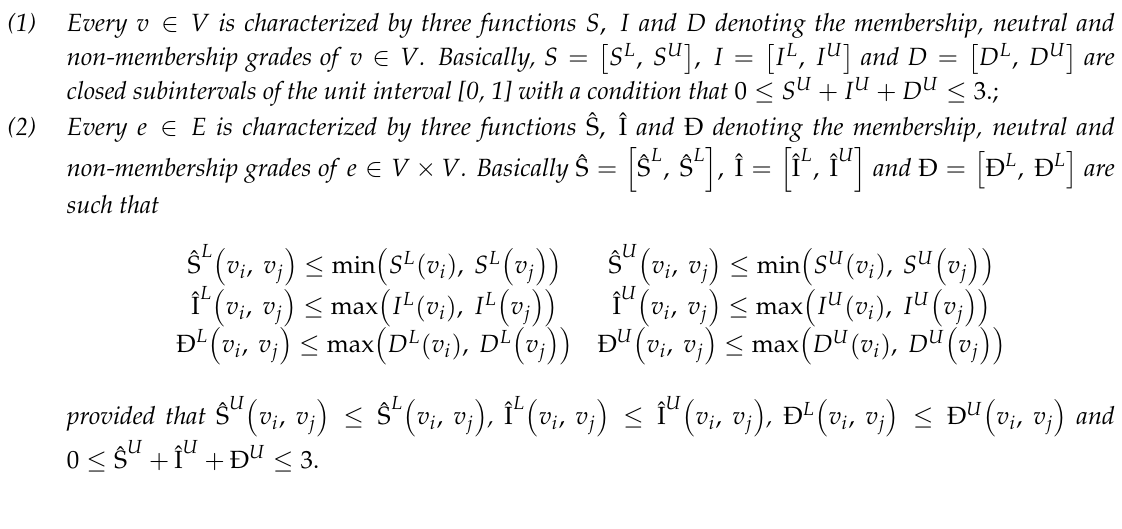
Figure 21. Interval-valued neutrosophic graph with undefined intervals.